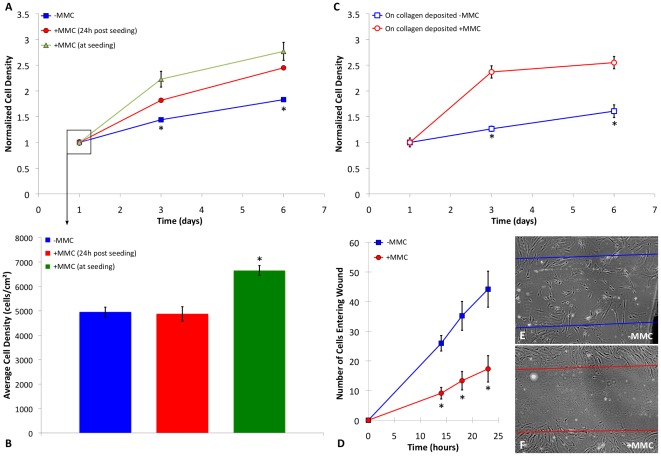
Consequences of altered extracellular matrix organization include enhanced proliferation, altered adhesion, and decreased migration.(A) Human bone marrow-derived mesenchymal stromal or stem cells (MSCs) cultured in media containing macromolecular crowders (+MMC media, filled red circle) demonstrate statistically significant increase in proliferation versus cells in −MMC media (filled blue square). Furthermore, cells seeded directly in +MMC media (filled green triangle) also demonstrate a similar increase in proliferation. (B) Cells seeded directly in +MMC media (green) demonstrate enhanced adhesion after 24 hours as compared to cells seeded without crowder (−MMC, blue +MMC (24 h post seeding), red). (C) MSCs cultured in basal media on collagen type-I deposited +MMC (open red circle) also exhibit similarly altered proliferation behavior compared to MSCs on collagen deposited −MMC (open blue square). (D) Migration of cells, as determined by a wound healing assay, is significantly reduced +MMC (open red circle) (E) as compared to −MMC (open blue square) (F) (N = 9). Values are reported as mean ± standard error of measurement. * indicates statistical significance (p<0.001).